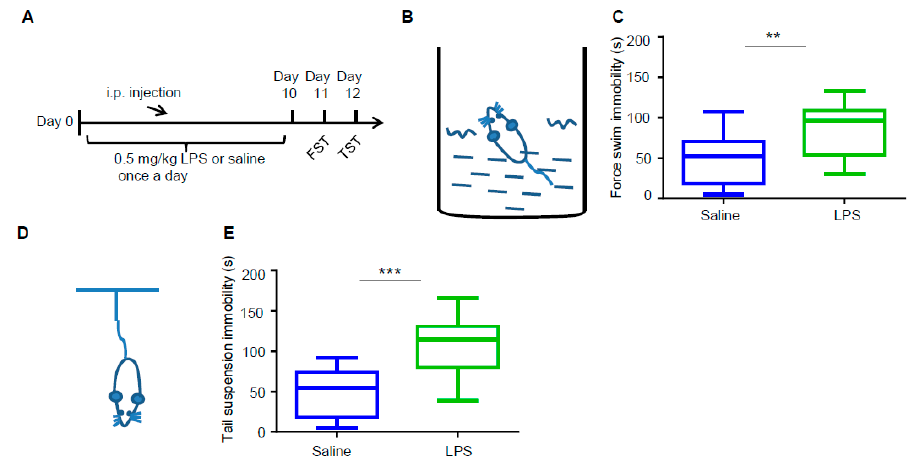
Figure 1. Lipopolysaccharide (LPS) induces depressive ‐ like behaviors in mice. ( A ) Schematic illustration of the experimental procedure for LPS administration and behavioral tests for depressive ‐ like behaviors in mice. C57BL/6 male mice at age of 6–7 weeks were intraperitoneally (i.p.) injected with 0.5 mg/kg LPS or an equal volume of saline daily for 10 days. The forced swimming test (FST) and tail suspension test (TST) were conducted at 24 and 48 h after the LPS treatment. After the behavioral tests, these mice were sacrificed for brain morphological analysis. ( B , C ) LPS treatment significantly increased the immobility time in FST. ( B ) Schematic diagram of mouse FST. ( C ) Quantification of the immobility time (s) in 4 min for each group of mice in FST. Data are shown as mean ± SEM (n = 14 mice for each group, Student’s t ‐ test, ** p < 0.01). ( D , E ) LPS treatment significantly increased the immobility time in TST. ( D ) Schematic diagram of mouse TST. ( E ) Quantification of the immobility time (s) for each group of mice in TST. Data are shown as mean ± SEM (n = 14 mice for each group; Student’s t ‐ test, *** p < 0.001).